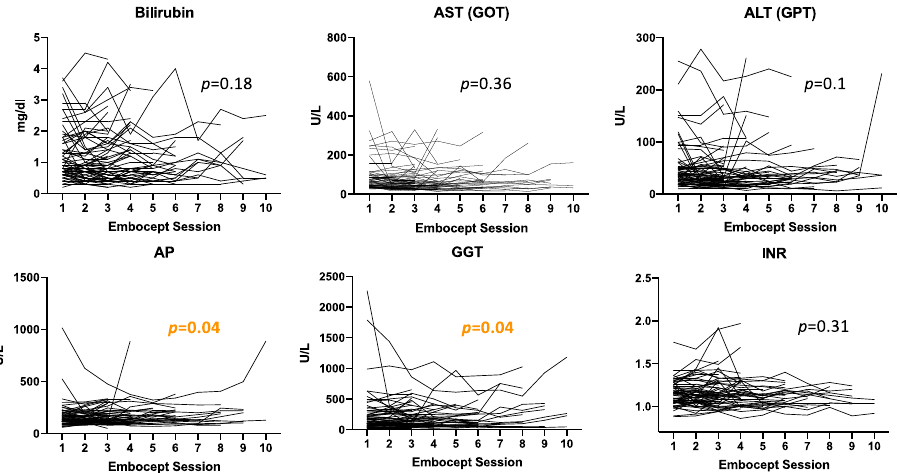
Figure 4. Laboratory changes over time. Laboratory values before each treatment session are graphed for individual patients. Laboratory values graphed are AST (aspartate-aminotransferase); ALT (alanine-aminotransferase); AP (alkaline phosphatase); GGT (gamma-glutamyltransferase); and INR (international normalized ratio).